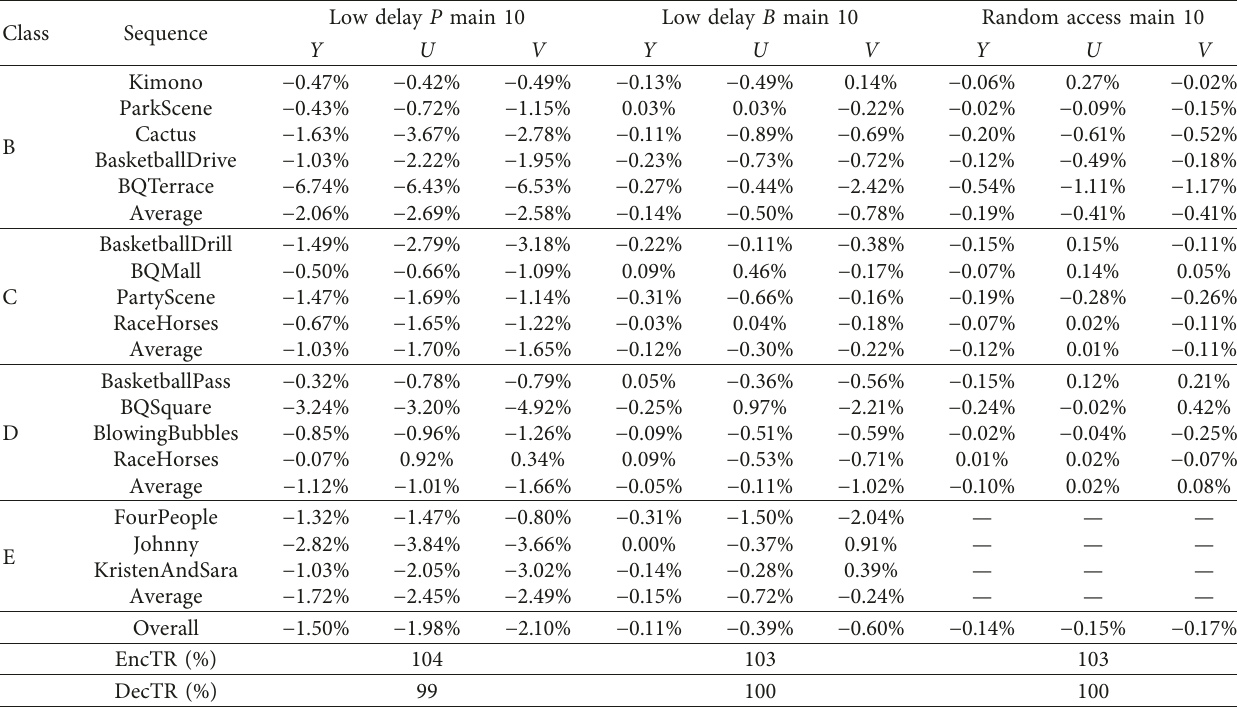
Table 2: BDBRs and codec time ratios of the proposed method compared to the JEM 7